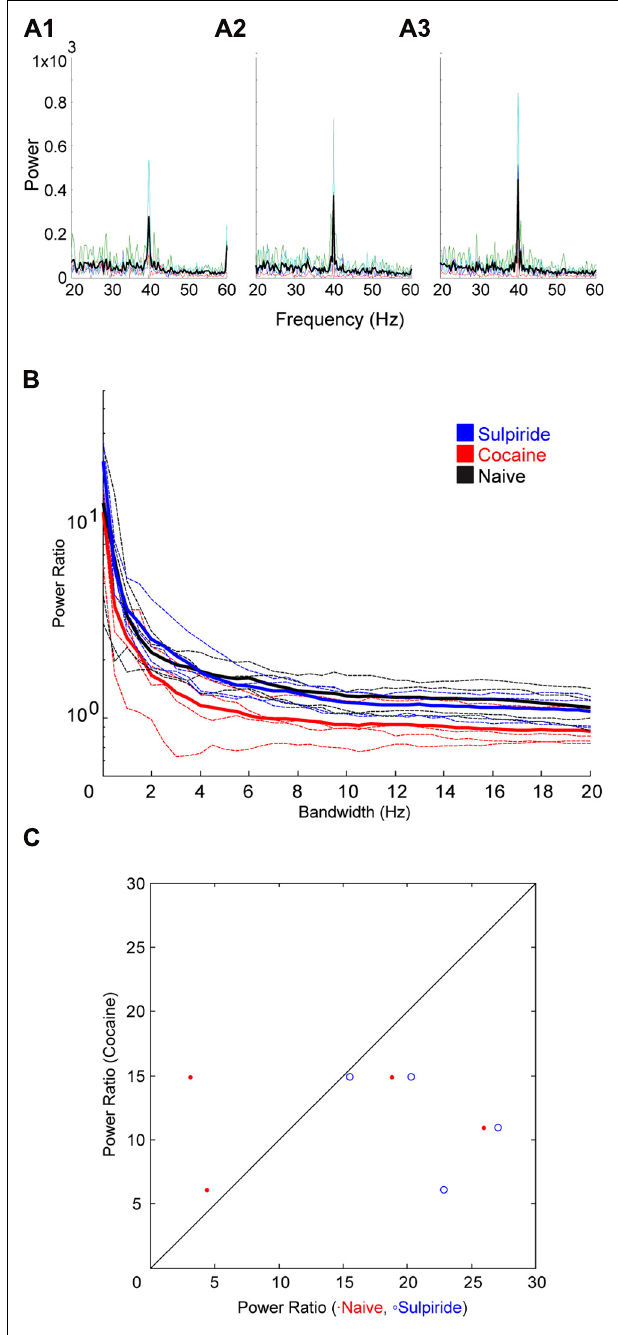
FIGURE 6 | Effect of the D2 antagonist Sulpiride on cocaine induced change to the induced oscillation. (A) Power spectra around the stimulated frequency in naïve (A1), cocaine (A2), and Sulpiride (A3) conditions. Sharpening of the peak is seen here again and appears to be enhanced by Sulpiride. (B) Power ratio vs. bandwidth plot reflecting the changes in peak power and bandwidth seen above. Sulpiride appears to increase the sharpening effect of cocaine treatment. (C) Comparison of power ratio at the peak, across treatment conditions. Above the line represents a larger power ratio in cocaine treatment vs. either naïve (red) or Sulpiride (blue). Sulpiride data points are shifted to the right demonstrating that Sulpiride may increase the peak power further than